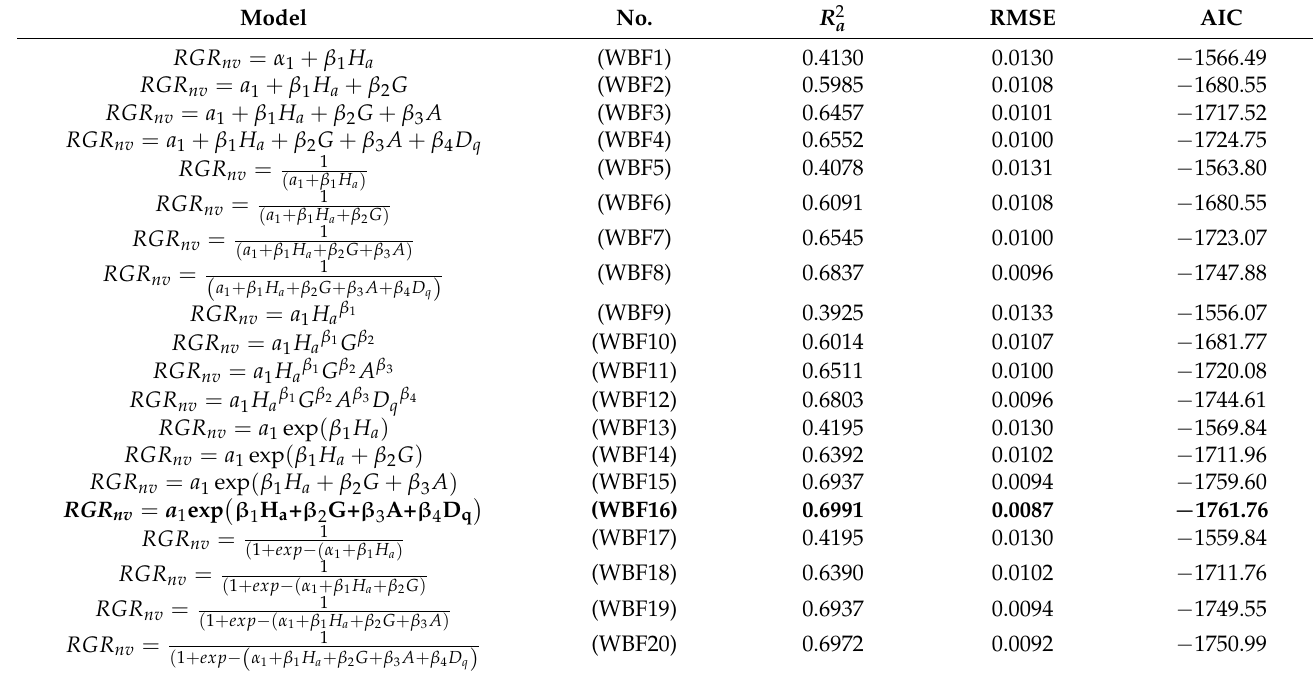
Table A2. Goodness-of-fit statistics of the basic RGR nv equations for white birch forest (WBF). Model